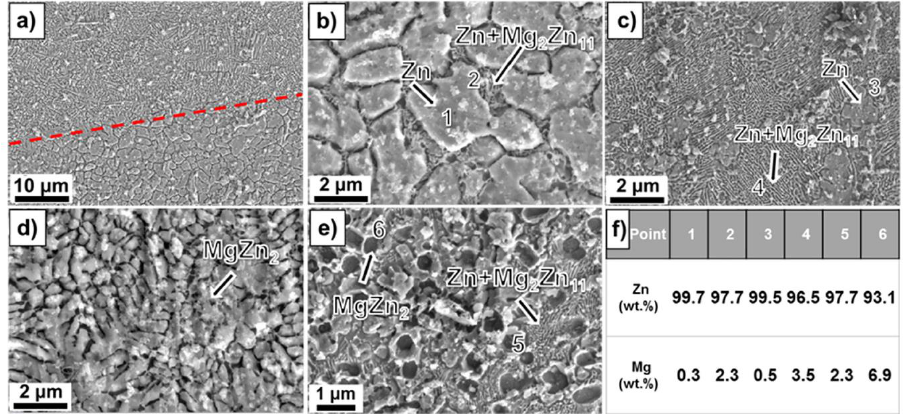
Figure 7. Microstructure analysis: ( a ) and ( b ) Zn-2WE43; ( c ) and ( d ) Zn-5WE43; ( e ) Zn-8WE43, ( f ) element ratio obtained through EDX analysis [130]. Figure is licensed under CC − BY − NC − ND 4.0. Reprinted with permission from ref. [130]. Copyright Elsevier, 2022.